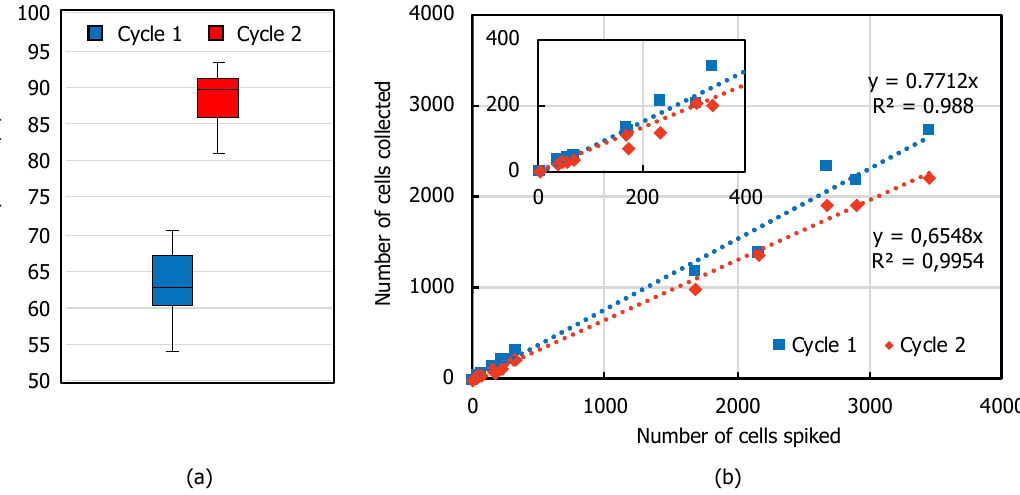
Figure 7. ( a ) A box-plot of WBC depletion (n = 15) and ( b ) linear fit of CTC recovery after first and second cycle of the spiral microfluidic chip process at different spiking rates (50–3500 CTCs/5 mL blood. Inset shows the zoomed view for spiking values < 400 CTCs.